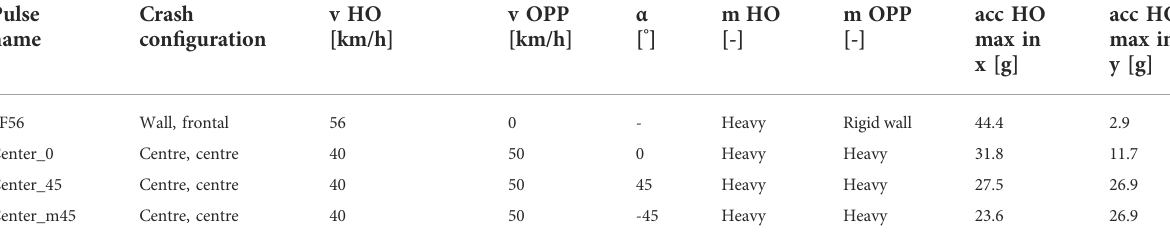
TABLE 1 Simulation con fi gurations for crash pulse generation.